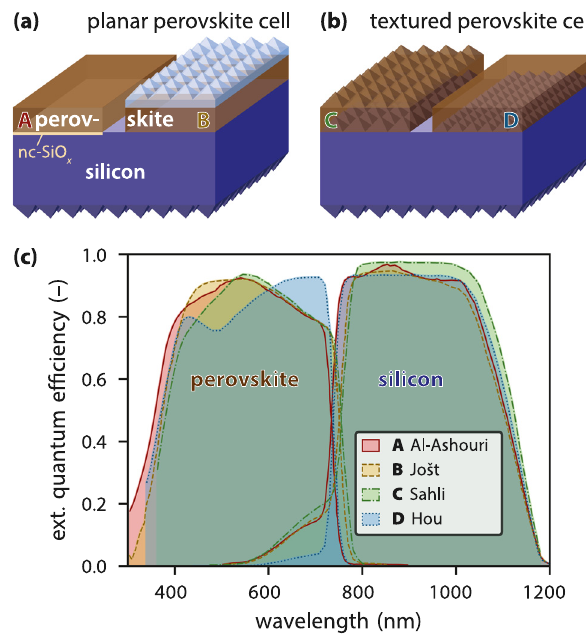
Figure 1: Experimental results for perovskite/silicon tandem solar cells with different optical concepts. (a) Solar cells with a planar ) perovskite top cell with A , a nanocrystalline silicon oxide (nc-SiO x interlayer and with B, a textured foil on top. (b) Tandem solar cell with textured perovskite layers, where the perovskite layer is either C fully textured or D just textured on the rear side. (c) Best experimental results representing the four architectures illustrated in (a) and (b): A intermediate nc-SiO layer (Al-Ashouri et al. [5]), B x planar perovskite cell with textured foil on top (Jošt et al. [21]), C fully textured perovskite cell (Sahli et al. [25]), and D perovskite cell with textured back and planar front (Hou et al.